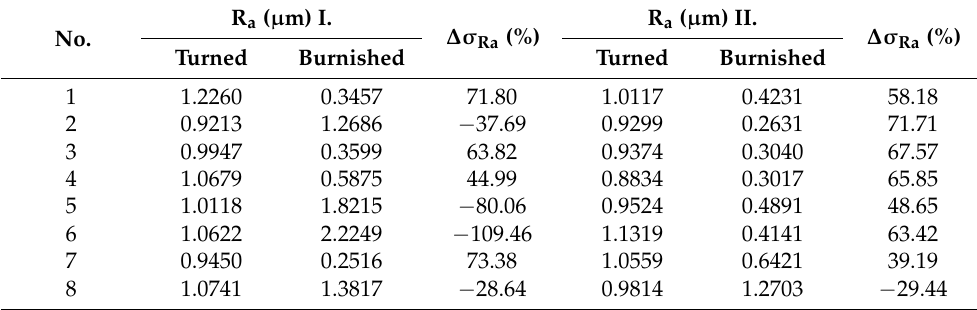
Table 4. The measured values and the calculated improvement ratios for R a .